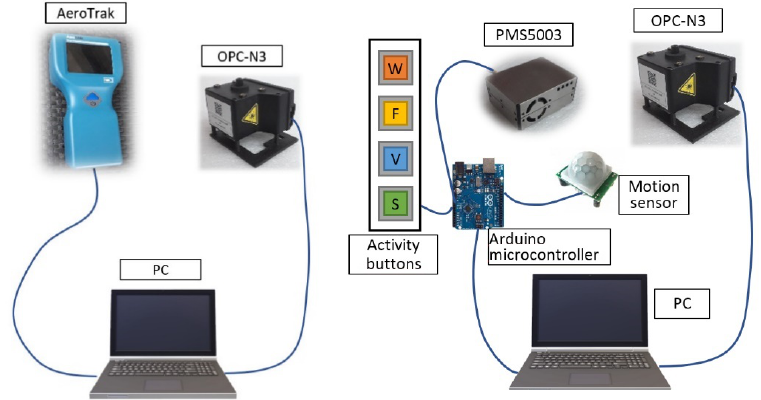
Figure 1. Experimental setups used in the first campaign ( left ) and in the second campaign ( right ).